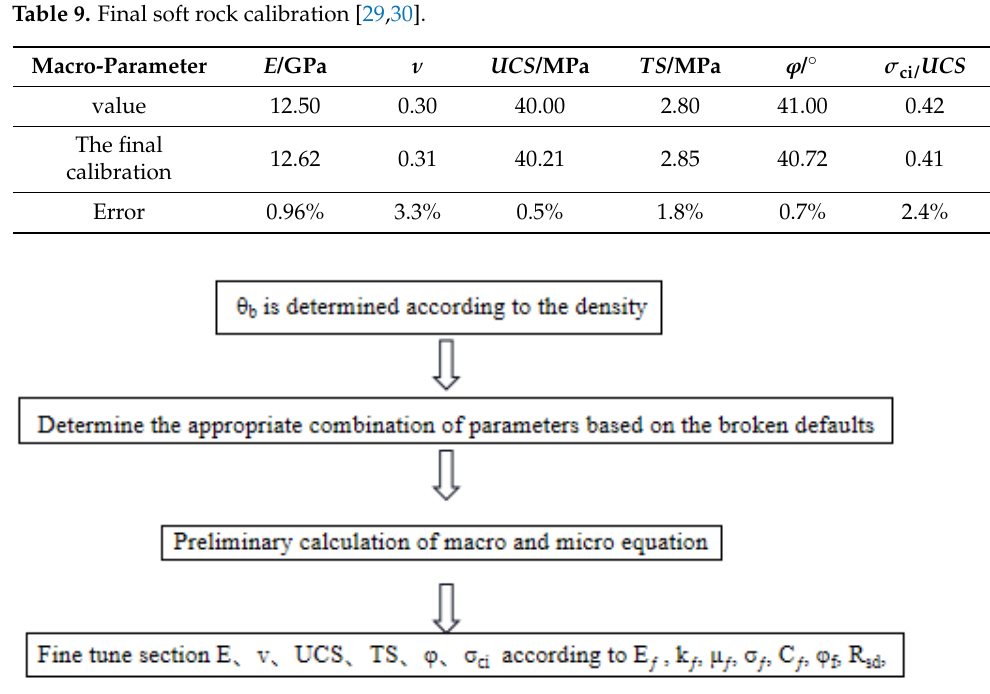
Figure 12. Calibration flow